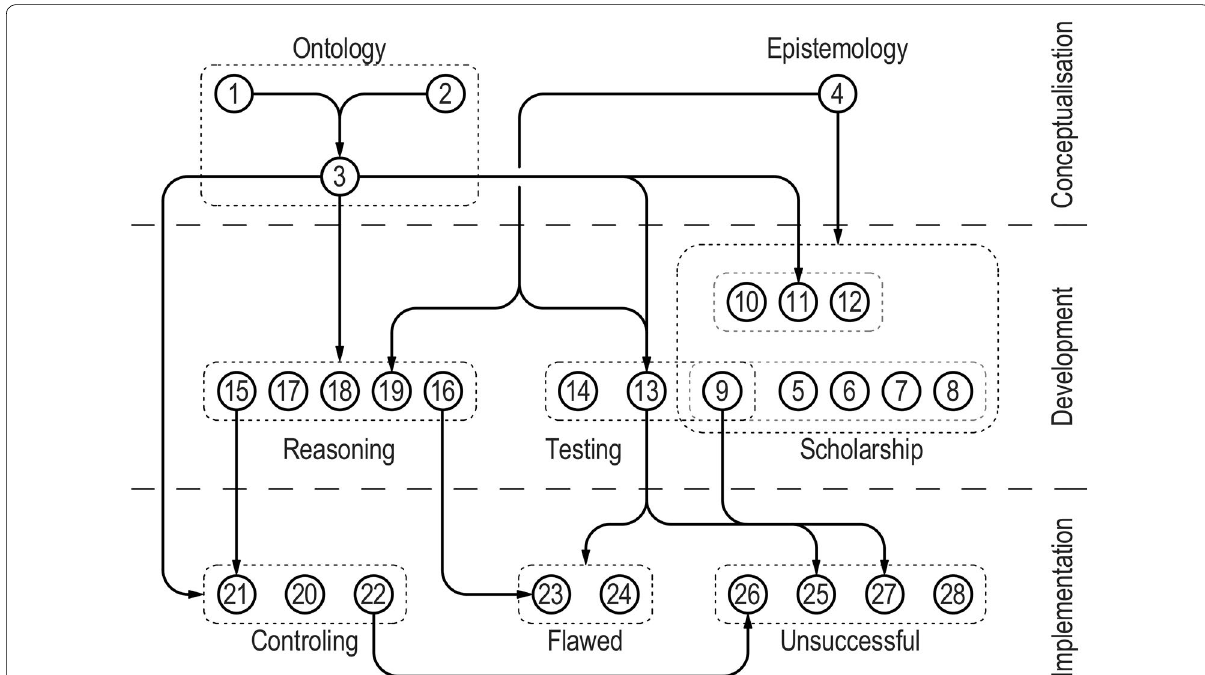
Fig. 3 Criticism connections and groupings of Alexander’s second theory of architecture: Implementation and outcomes. Numbers correspond to criticism numbers in text and tables, dotted lines indicate groups and sub-groups of criticisms, arrows point from antecedent criticisms to second- ary criticisms or groups of criticisms